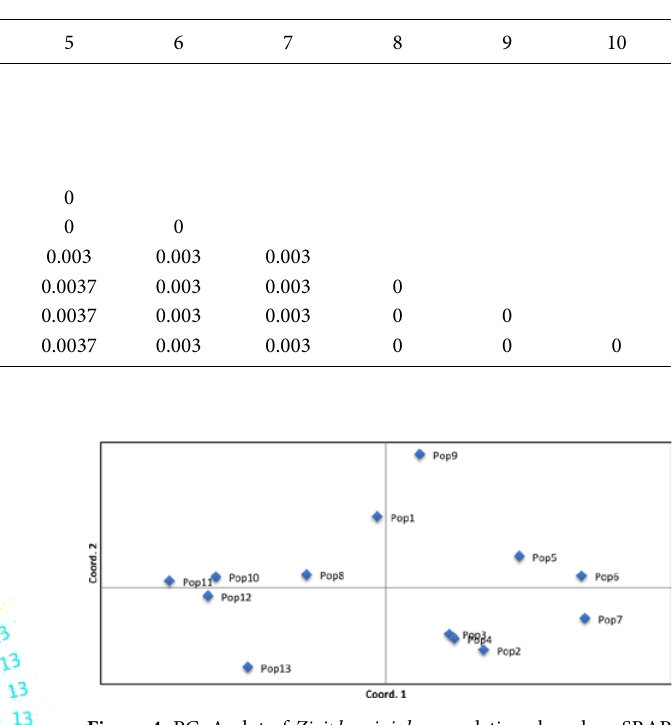
Figure 4. PCoA plot of Ziziphus jujube populations based on SRAP molecular markers. (Populations 1-13 are according to Table 1).